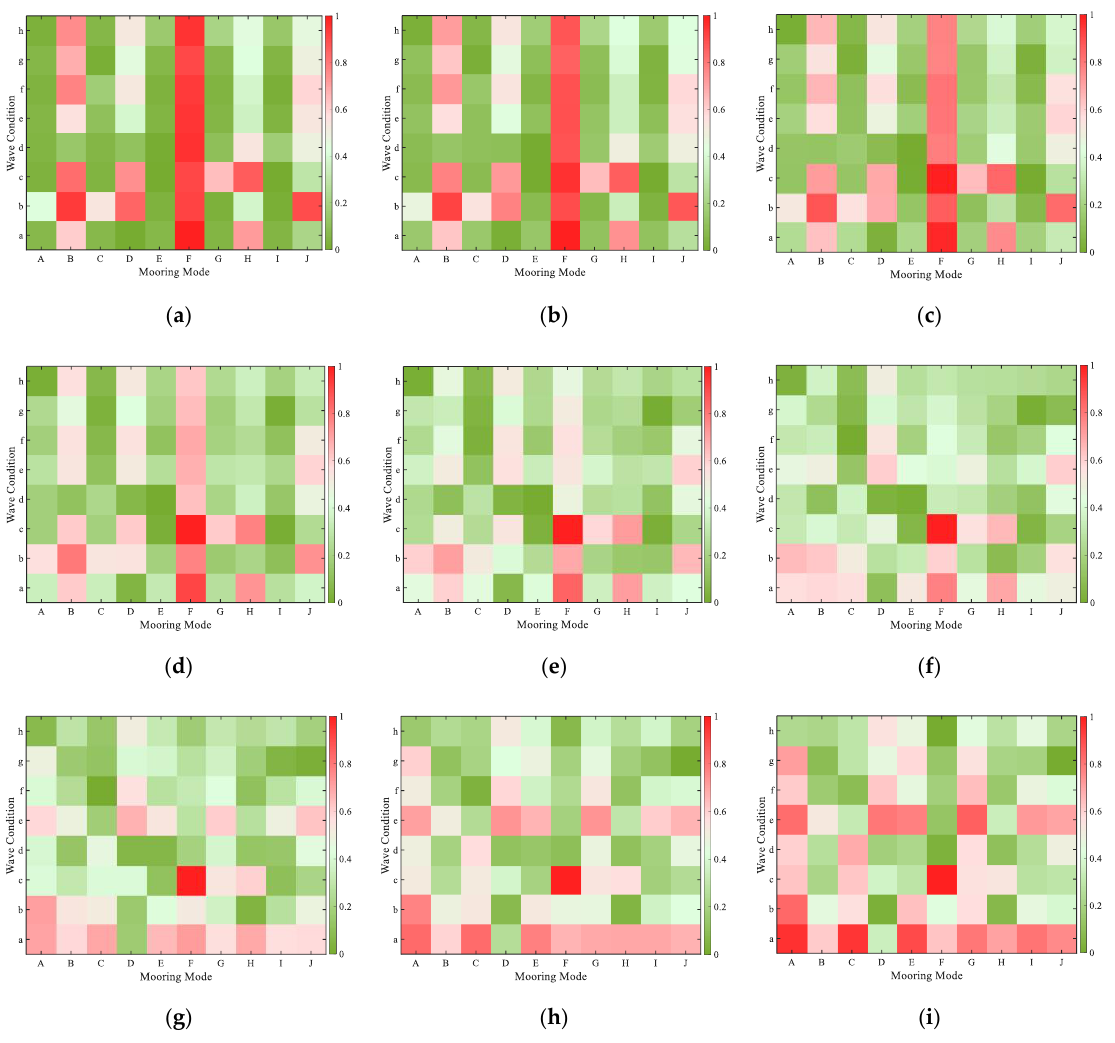
Figure 21. The cloud chart of the comprehensive performance index with different weighting com- binations. ( a ) a t = 0.1, a n = 0.9 . ( b ) a t = 0.2, a n = 0.8 . ( c ) a t =0.3, a n = 0.7 . ( d ) a t = 0.4, a n = 0.6 . ( e ) a t = 0.5, a n = 0.5 . ( f ) a t = 0.6, a n = 0.4 . ( g ) a t = 0.7, a n = 0.3 . ( h ) a t = 0.8, a n = 0.2 . ( i ) a t =0.9, a n = 0.1